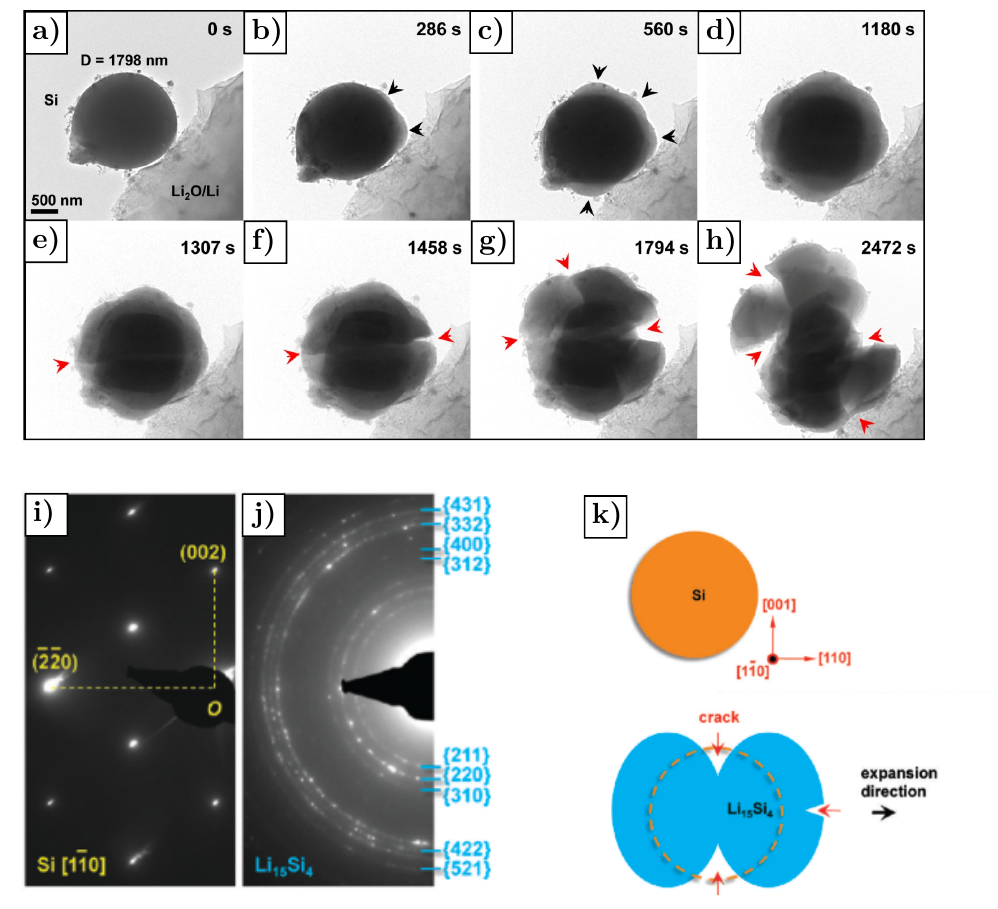
Figure 8. ( a – h ) Crack growth during single lithiation cycle in silicon nano-particle. The black arrows mark the bumps due to anisotropic lithiation of Si before crack formation, whereas the red arrows mark the cracks. ( i , j ) Electron diffraction pattern showing the silicon phase transformation from ( i ) crystalline structure (Si) to ( j ) polycrystalline structure (Li 15 Si 4 ). ( k ) Anisotropic swelling in silicon nanoparticle favoring cracks in [110] direction. Reprinted with permission by American Chemical Society from [51], Copyright